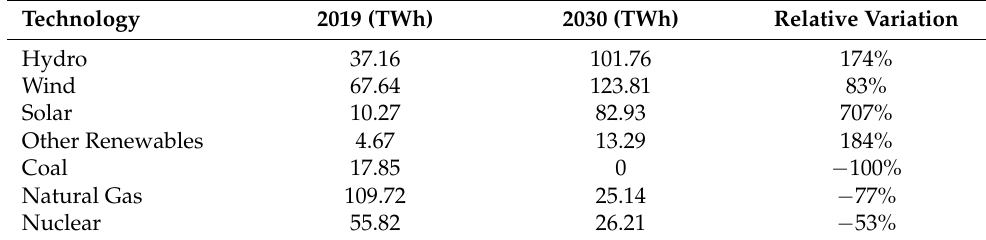
Table 3. MIBEL energy mix simulation for 2030 [7] and real values from 2019.